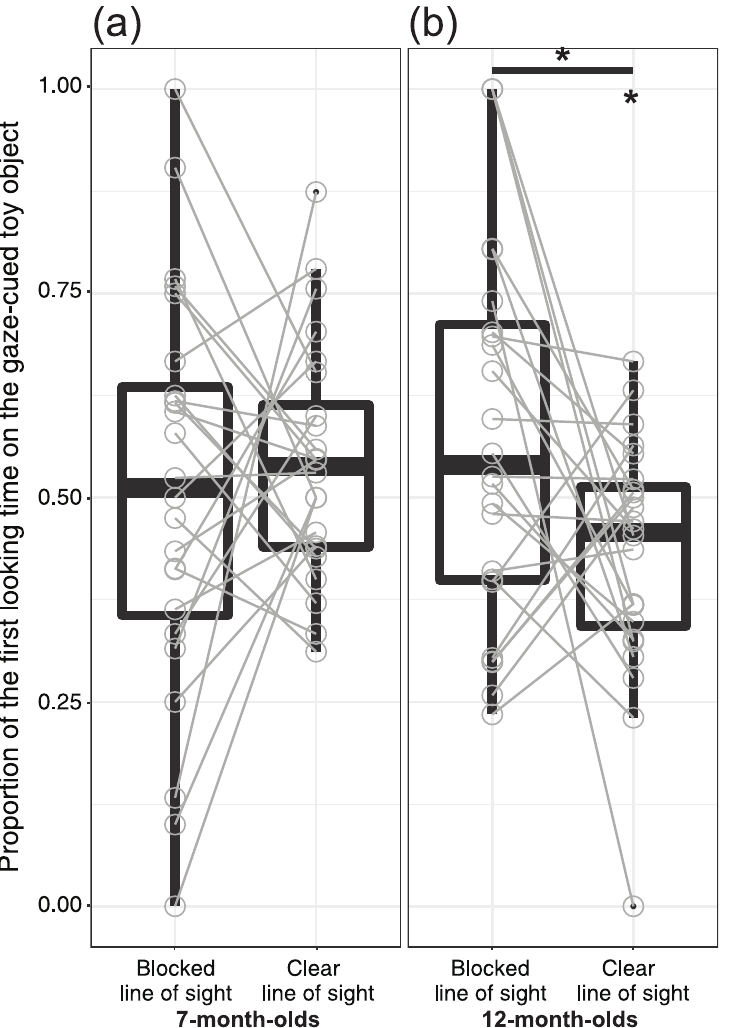
Fig 3. Proportion of the first looking time on the gaze-cued toy object for the Blocked Line of Sight and Clear Line of Sight Conditions. Results are shown for the (a) 7-month-old infants and (b) 12-month-old infants. The central mark indicates the median, and the bottom and top edges of the box indicate the 25th and 75th percentiles, respectively. The upper whisker (vertical line) extends from the third quartile to the largest value. However, this was no further than the 1.5 interquartile ranges from the third quartile. The lower whisker extends from the 25th percentile down to the smallest value. However, this was no further than 1.5 interquartile ranges from the first quartile. � p <